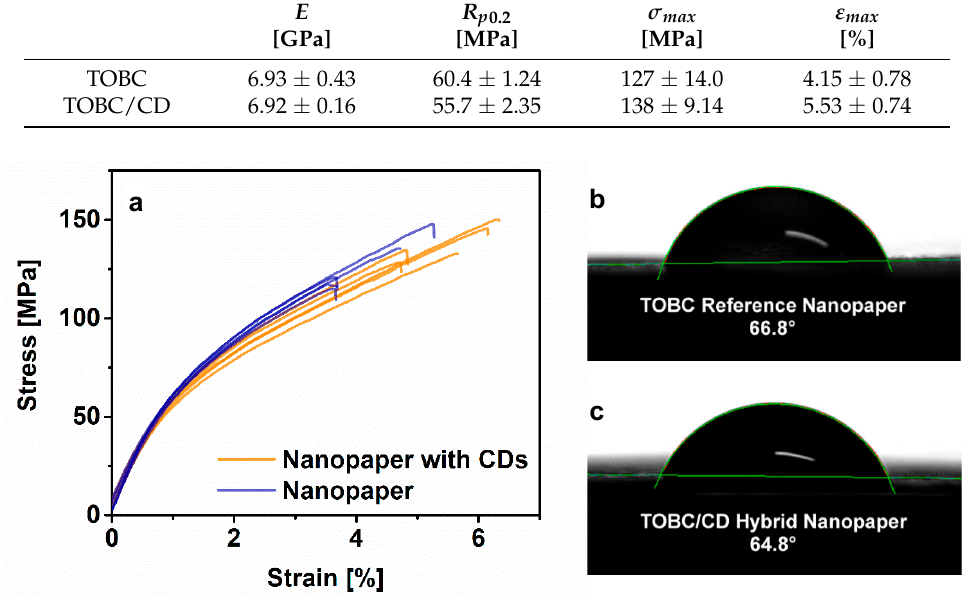
Figure 8. Response of TOBC reference and TOBC/CD hybrid nanopaper towards tensile stress ( a ). Water contact angle 10 s after a droplet had been placed on the surface of TOBC reference ( b ) and TOBC/CD hybrid nanopaper ( c ).